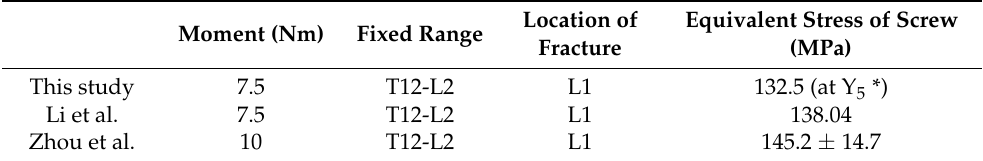
Table 2. Comparison of equivalent stress results of screws; flexion motion analysis in the frac- tured state. Location of Moment (Nm) Fixed Range